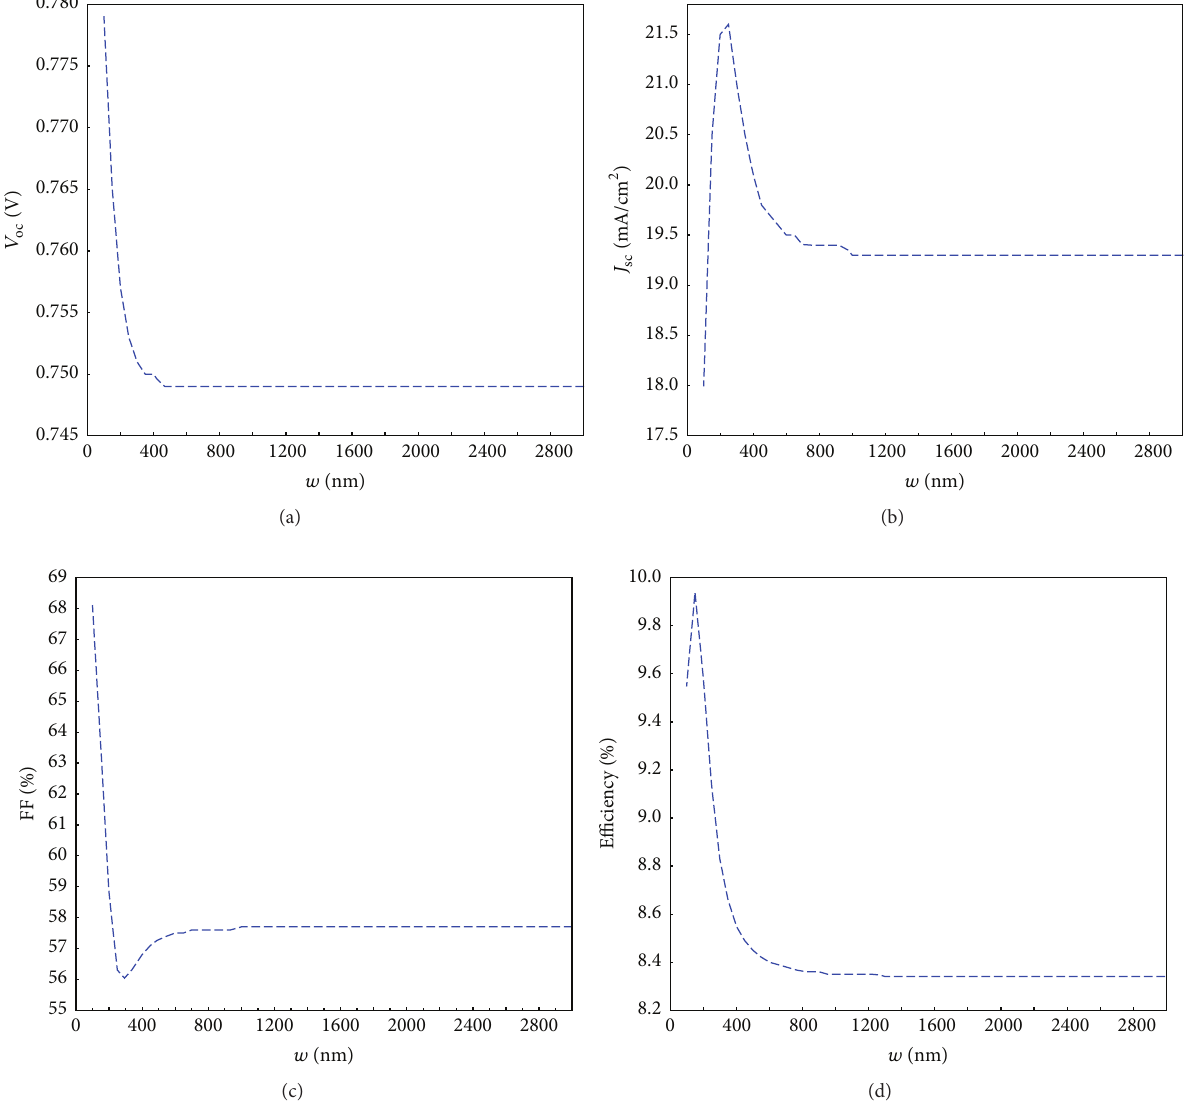
Figure 4: Absorber thickness effects on open-circuit voltage ( 𝑉 oc ), short-circuit density ( 𝐽 sc ), fill factor (FF), and efficiency.